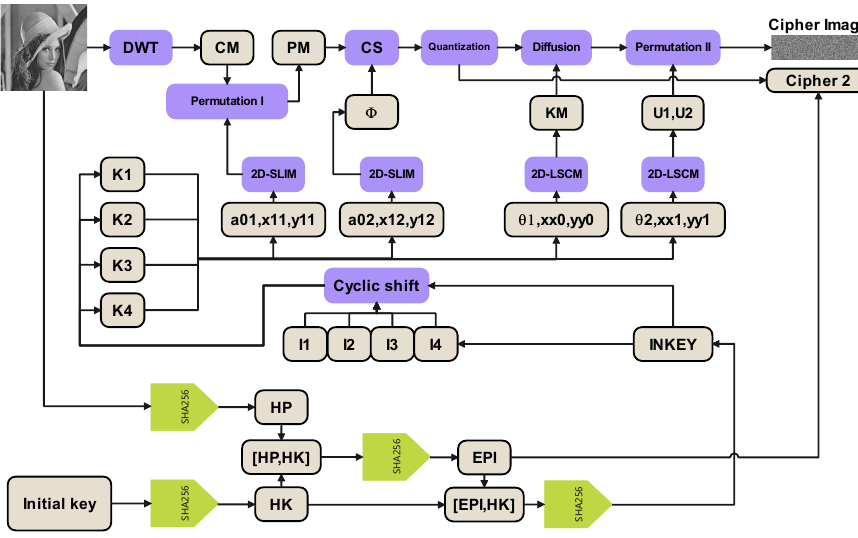
Figure 1. The block diagram of the encryption